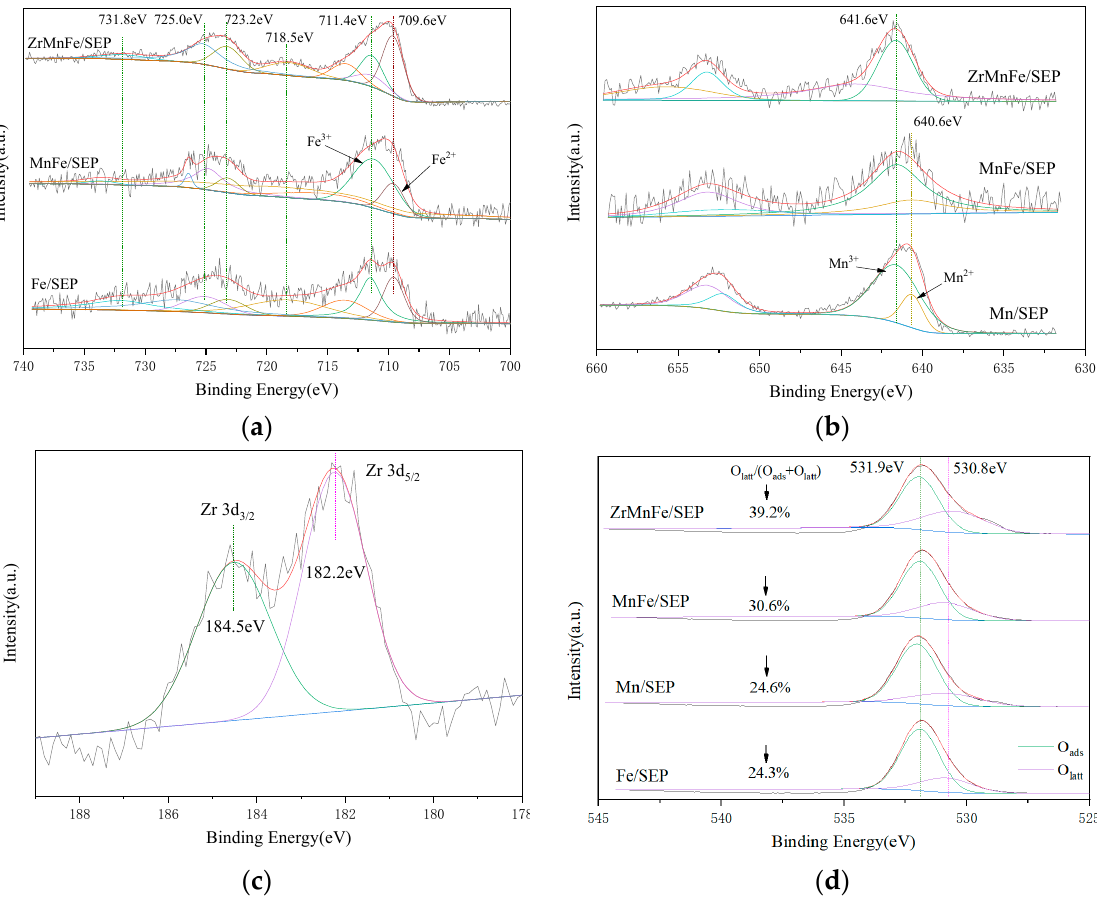
Figure 6. XPS pattern of ZrMnFe/SEP: ( a ) Fe 2p XPS spectra, ( b ) Mn 2p XPS spectra, ( c ) Zr 3d XPS spectra, ( d ) O 1s XPS spectra.